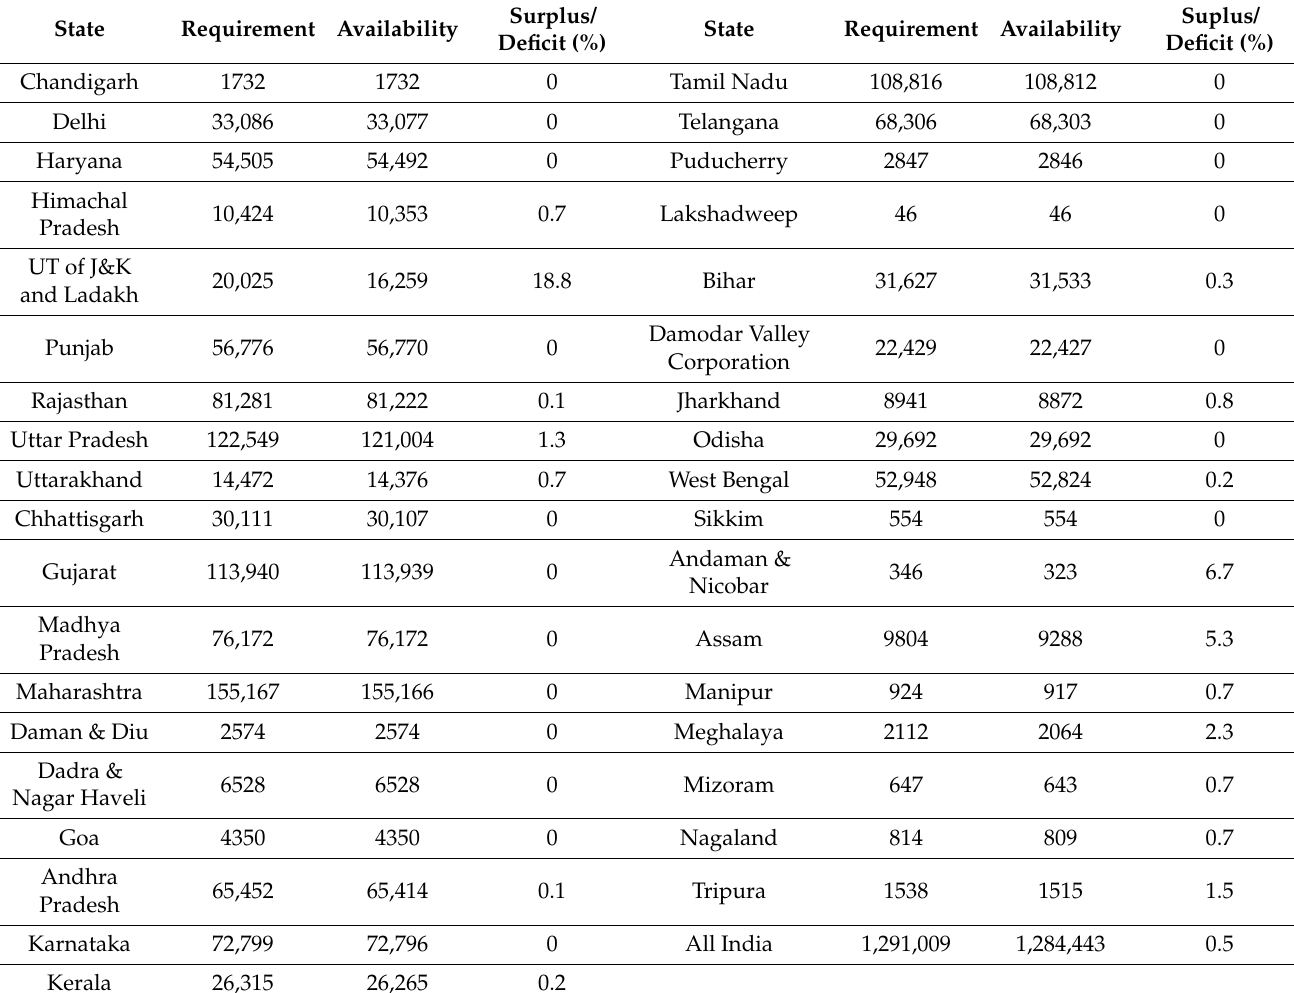
Table 8. India’s electricity supply status by state in the fiscal year 2019–2020, in MU. Source: Ministry of Power, Central Electricity Authority, Government of India